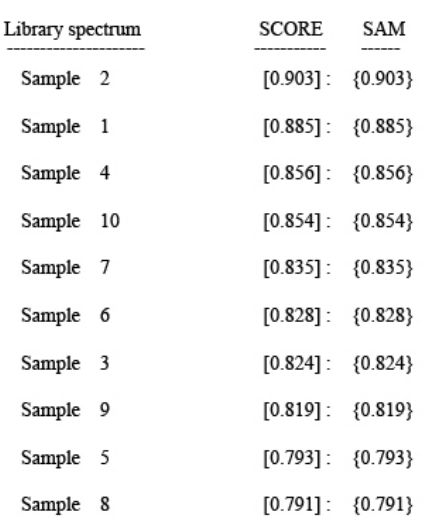
Figure 9. Results of the Spectral Analyst algorithm using Spectral Angle Mapper(SAM)